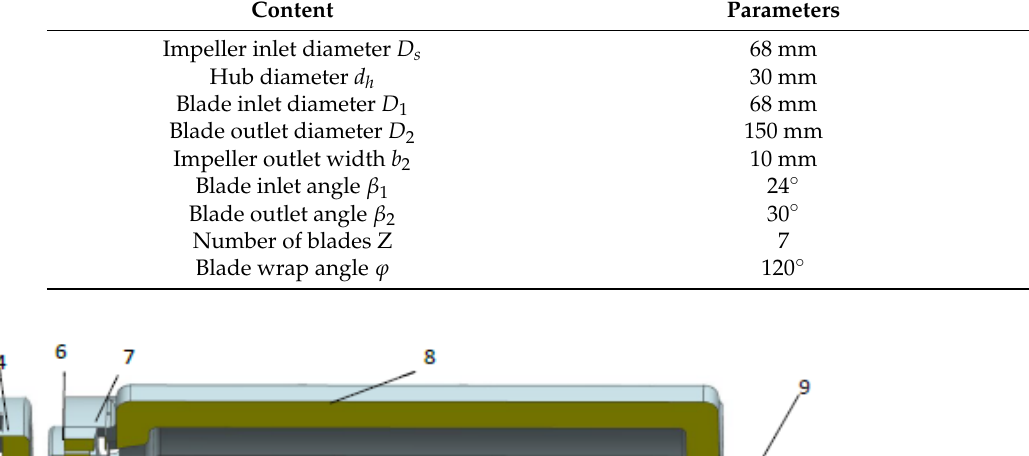
Figure 1. Water body assembly drawing of the LNG submersible pump.